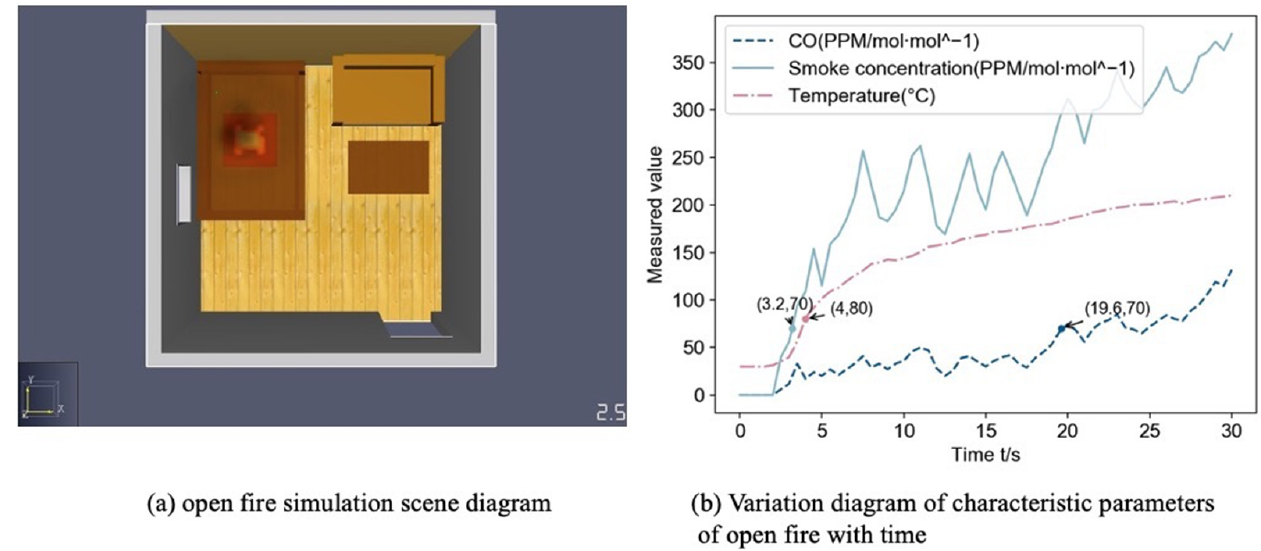
Figure 8. Open fire simulation information diagram.